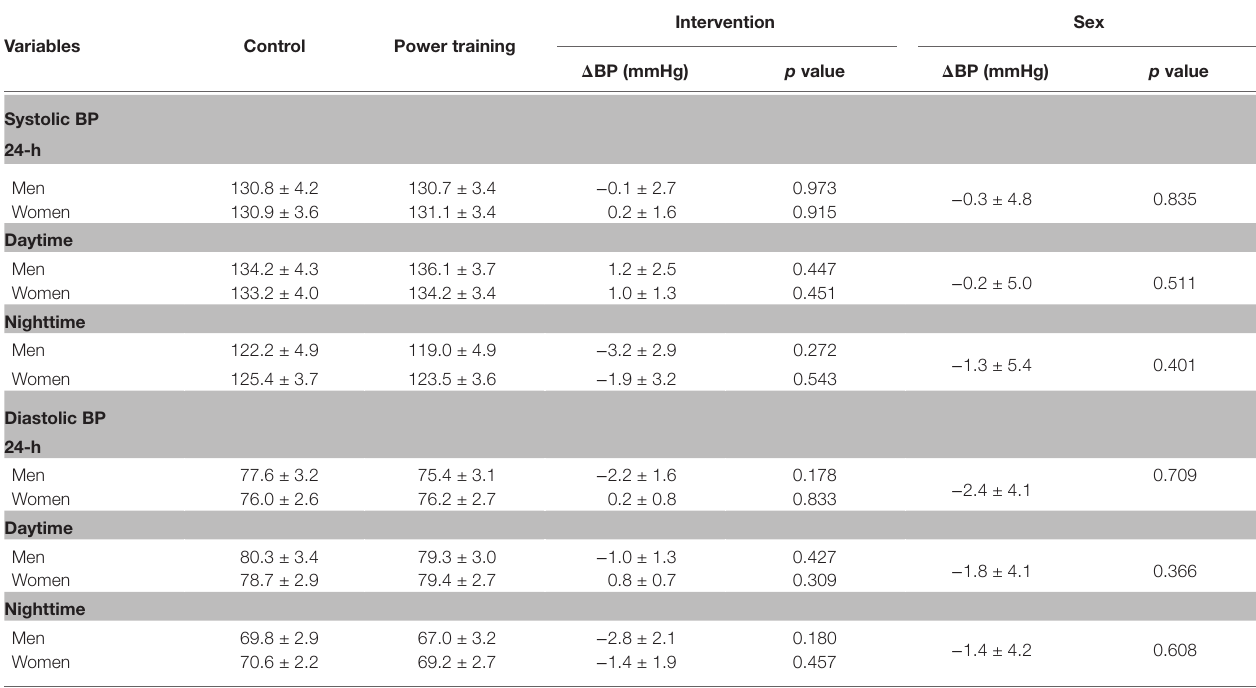
TABLE 3 | Ambulatory blood pressure measures after the power training and control sessions in men and women.